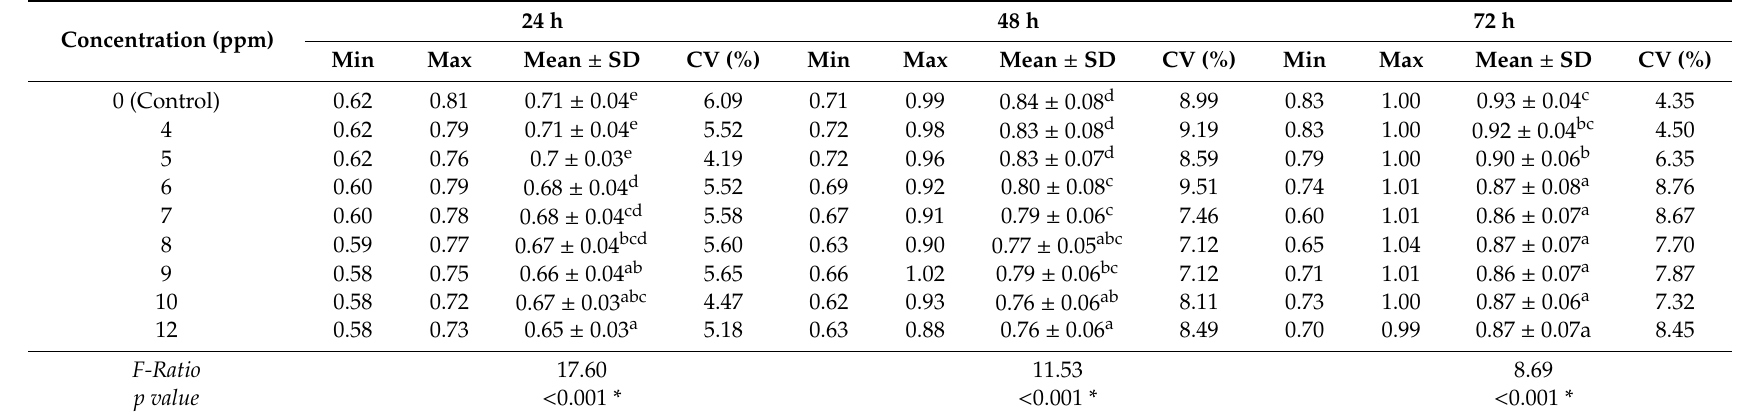
Table 2. Main summary statistics of body length measurements (mm) of Artemia nauplii exposed to di ff erent concentrations of SDS for 24, 48, and 72 h. * Significant di ff erences. Means with di ff erent superscript letter(s) are significantly di ff erent. Concentration